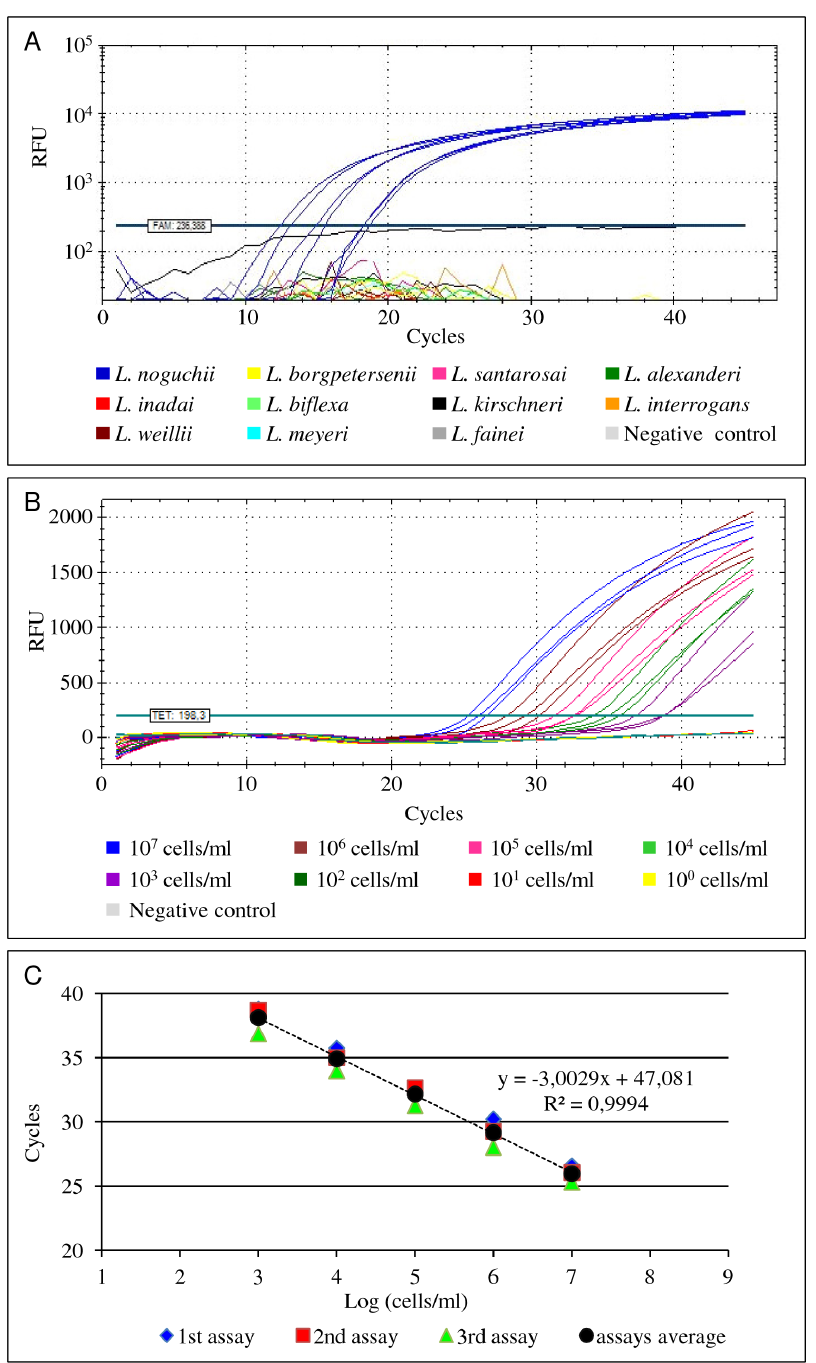
Figure 1. Illustration of the real-time PCR amplification curves obtained during the optimization of the assays. (A) Specificity tests of the L. noguchii targeted amplification assay using the TaqLnog probe combined with the flanking primers FLnog2 and RLnog2. Blue amplification curves represent L. noguchii strains. All other non-target strains yielded no amplification results. (B) Estimation of the limit of detection of the amplification assay targeting L. interrogans (serovar Autumnalis, strain Akiyami) using DNA extracted directly from spiked bovine kidney samples as template as a typical example of all Leptospira probe and primer sets. The amplification curves obtained from different ten-fold serial dilutions of the target Leptospira are represented by different colours. Unspiked tissue homogenate (grey line) was used as negative control. (C) Standard curve obtained from the analysis of the amplification curves mentioned in the previous panel B. RFU - Relative Fluorescence Units.